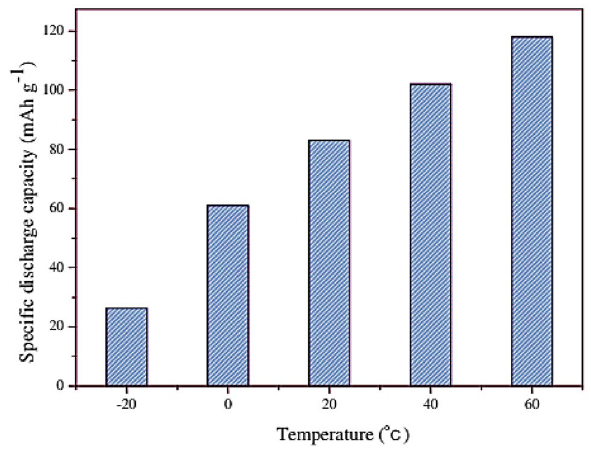
Fig. 7 Effect of temperature variance on the specific discharge capac- ity of the Li/PIN nanofiber cell [66]